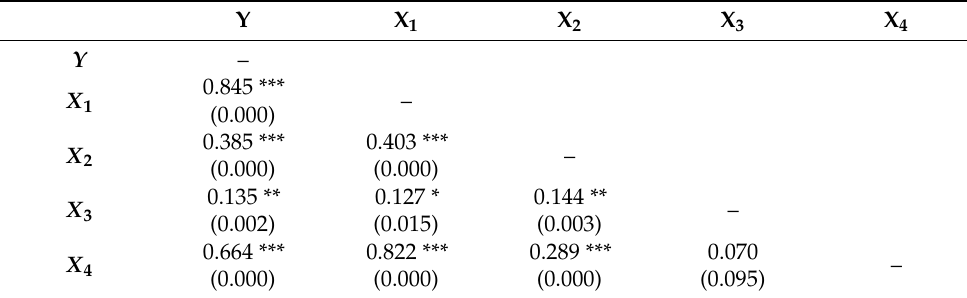
Table 4. QAP correlation analysis result.